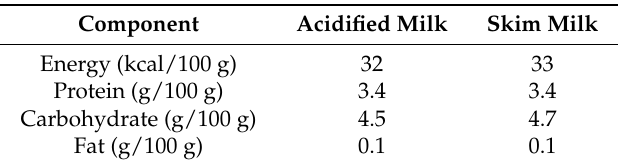
Table 1. The nutritional composition of the test solutions.